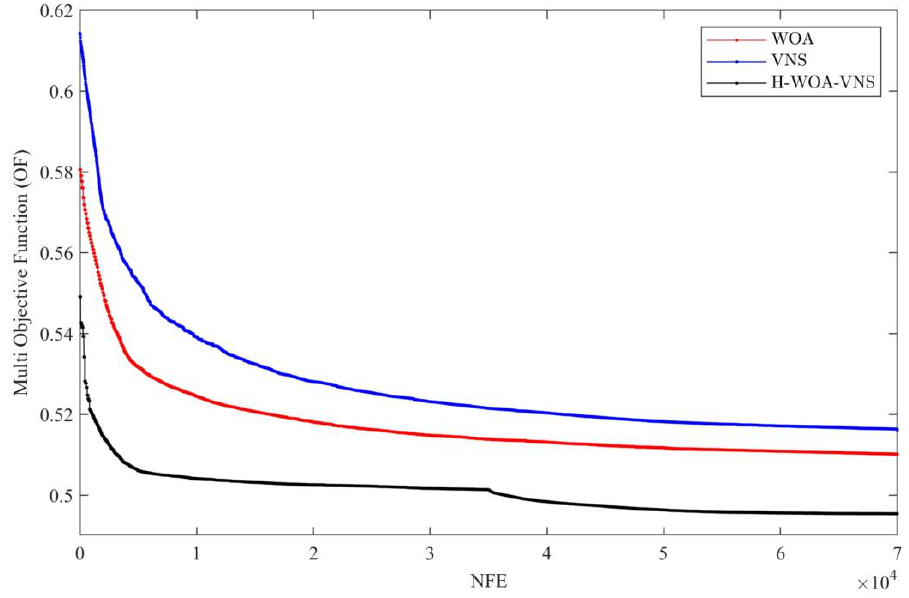
Figure 8. The best OF versus NFE obtained by WOA, VNS, and H-WOA-VNS. Table 16. Comparison of the H-WOA-VNS algorithm against other techniques, over 10 runs.